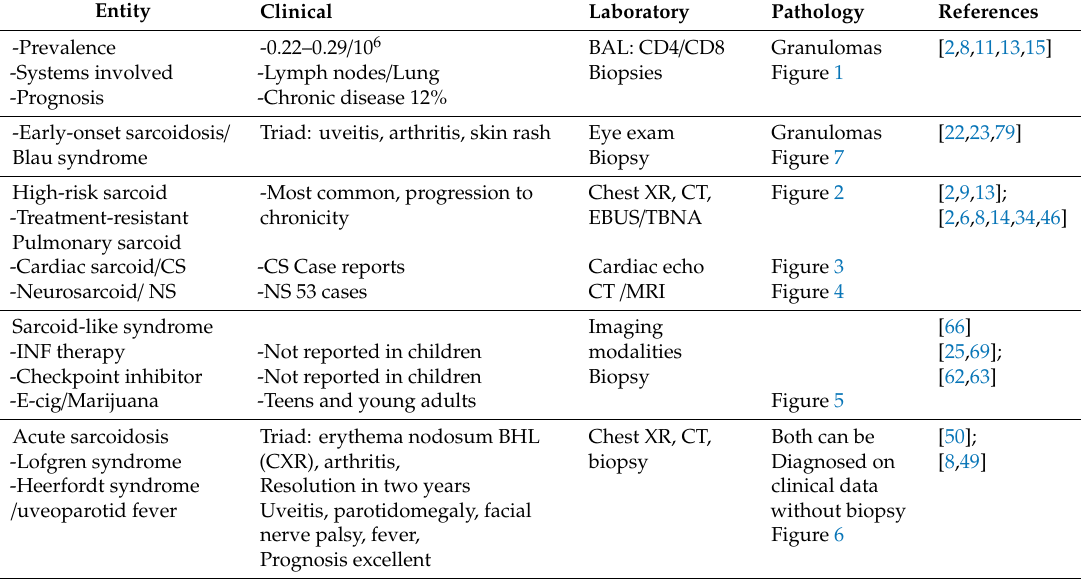
Table 1. Pediatric sarcoidosis—clinicopathologic